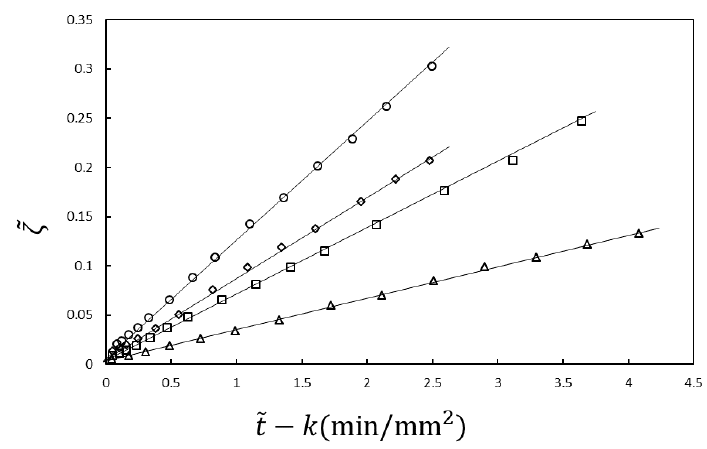
Figure 5. Gelation dynamics expressed by Equation (54) for horse plasma in contact with calcium chloride with concentrations of 10 mM ( △ ), 30 mM ( □ ), 50 mM ( ◊ ) and 100 mM ( ○ ).